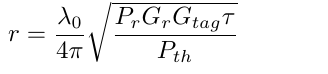
FIGURE 8: Simulated and measured reflection coefficients: (a) for 915 MHz, (b) for 868 MHz results are obtained using the same method described in [18].